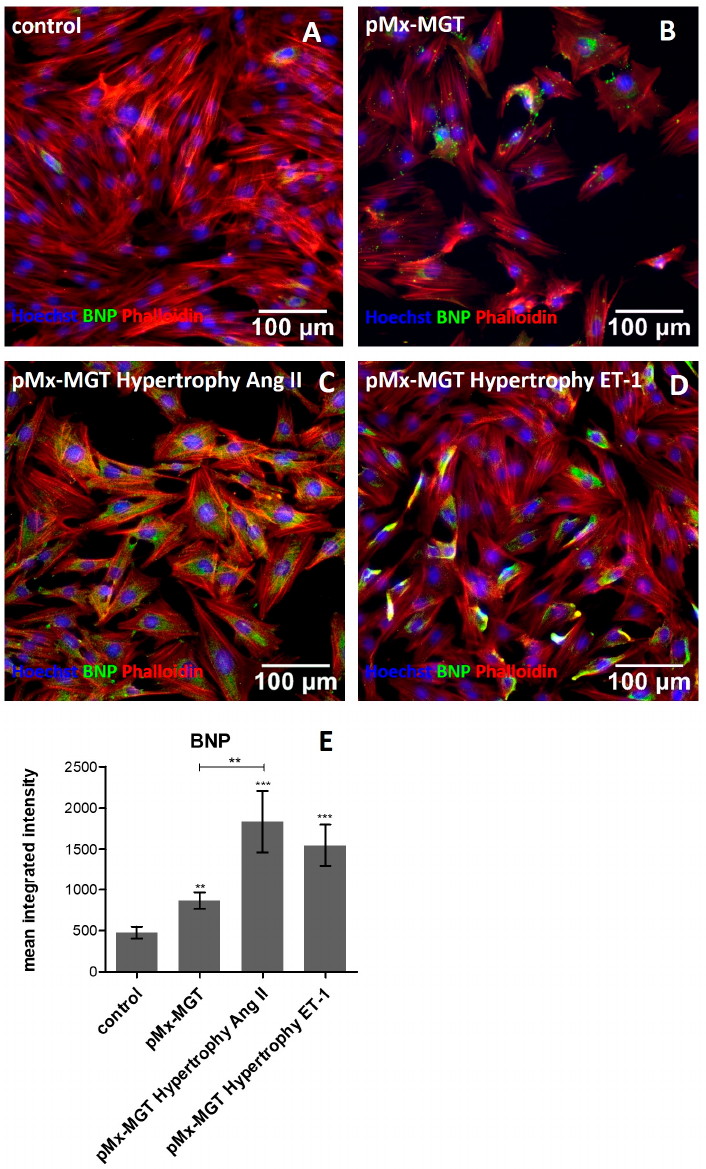
Figure 6. Immunofluorescence staining of BNP (green), cell nuclei (blue), and phalloidin (red). ( A ) Depicts BNP expression in control cells with a mean integrated intensity of 476.3 ± 328.6 pixels / cell. An increased BNP expression could be detected in ( B ) pMx-MGT -transfected pCPCs (862.2 ± 450.5 pixels / cell; p < 0.05), ( C ) pMx-MGT hypertrophy Ang II (1835.0 ± 1451.0 pixels / cell, p = 0.0006), and ( D ) pMx-MGT hypertrophy ET-1 (1547.0 ± 1128.0 pixels / cell, p = 0.0002). ( E ) Shows mean integrated intensities in all groups compared to control